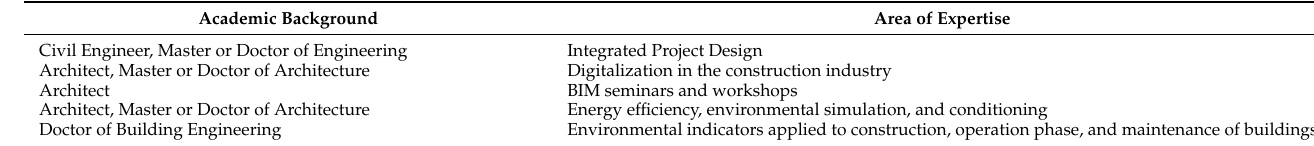
Table 2. Panel of experts with knowledge and experience in